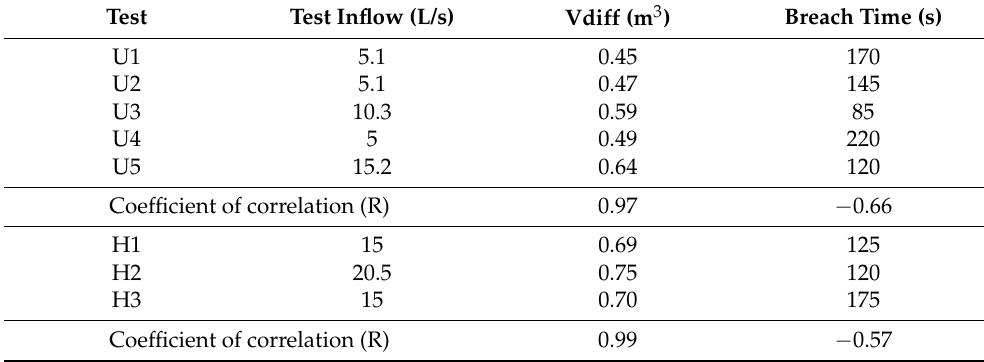
Table 2. Volume difference above dam footprint before and after